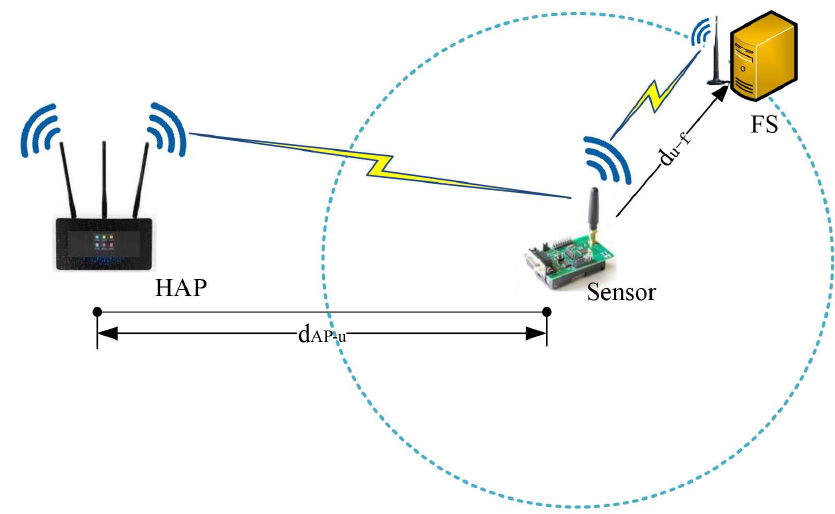
Figure 1. Illustration of the system model.